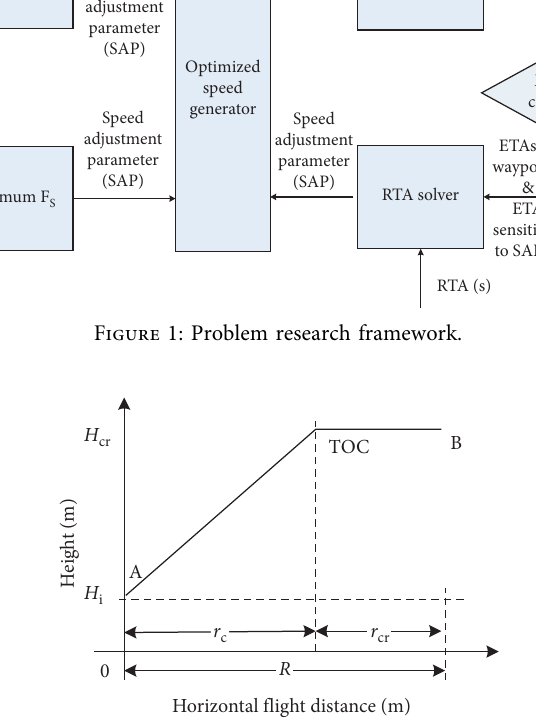
Figure 2: Aircraft departure model constrained by single